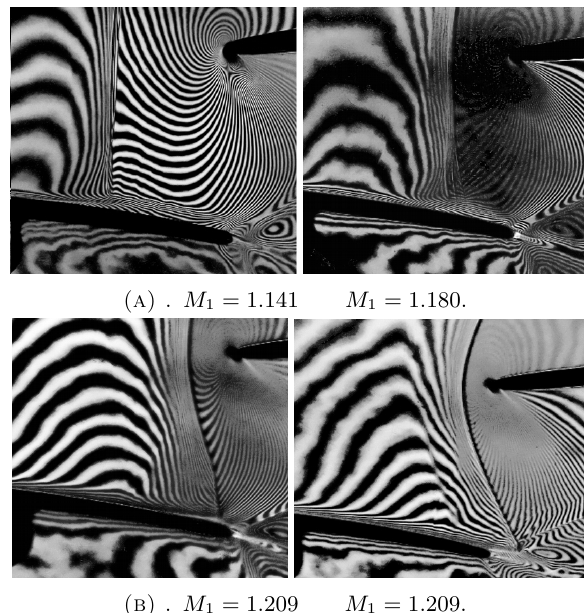
Figure 5. Development of the started supersonic flow.